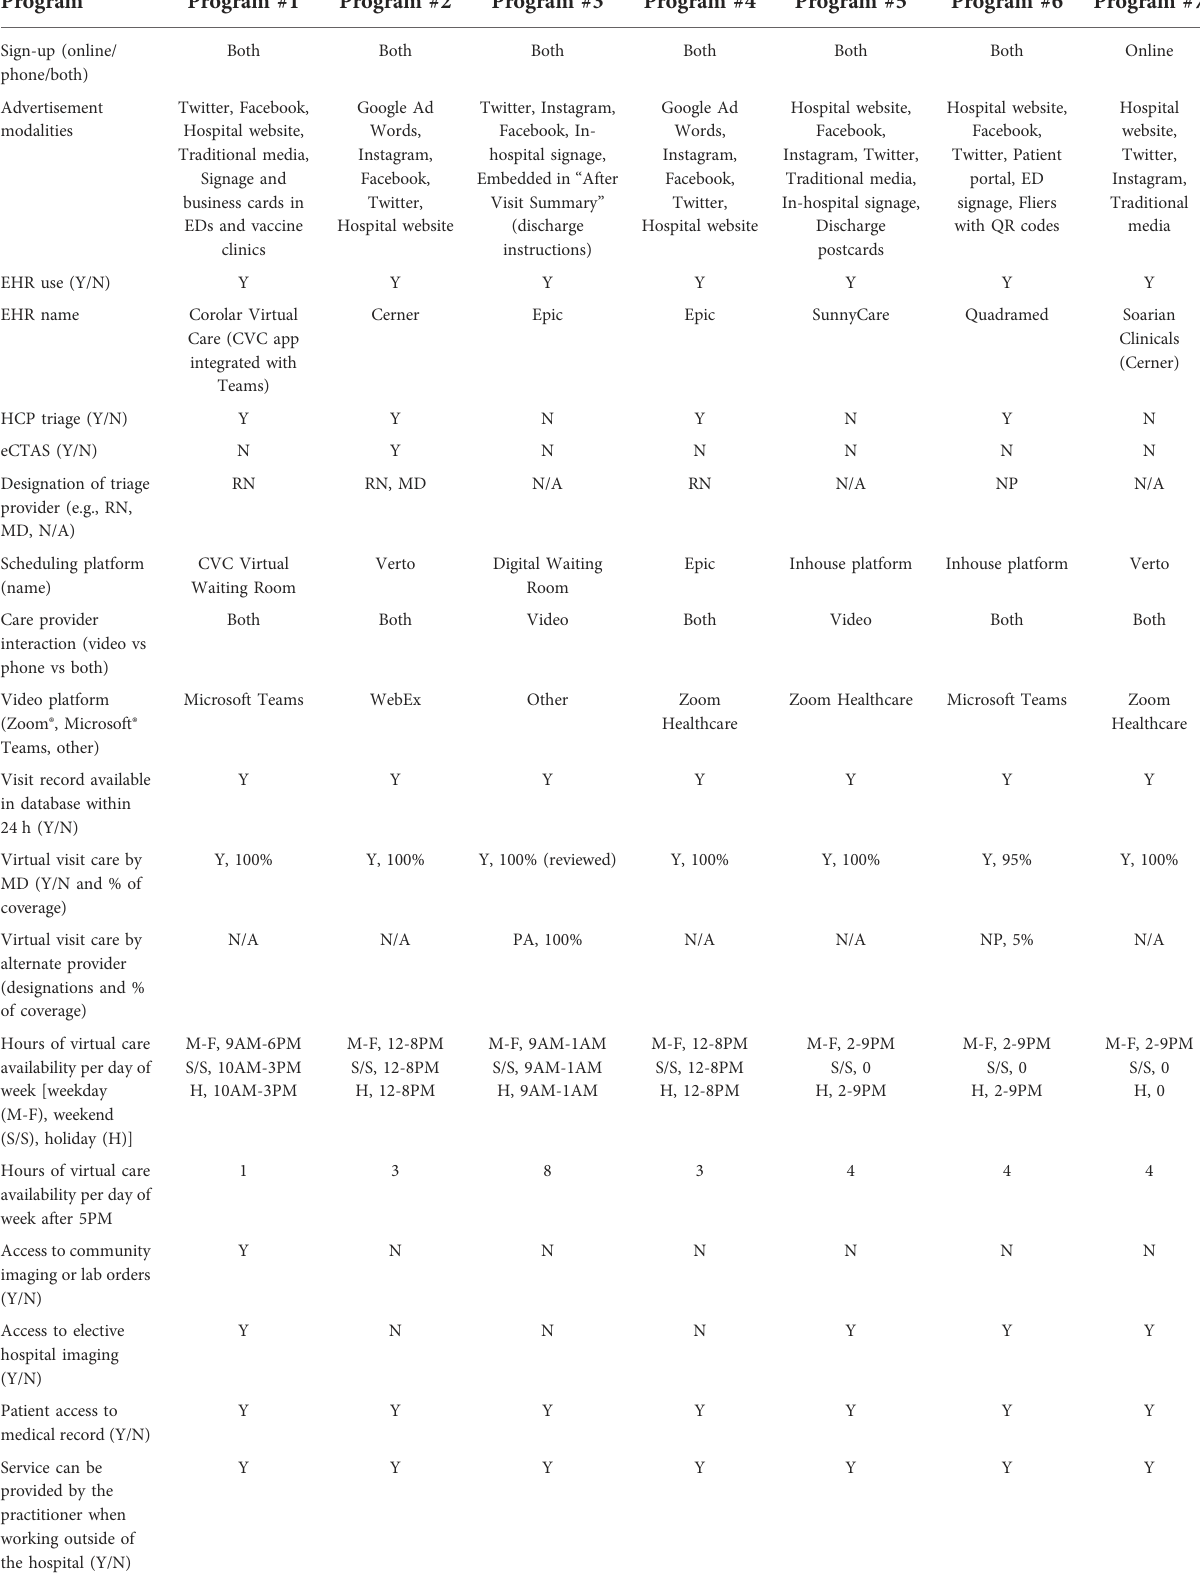
TABLE 1 Virtual urgent care pilot program models. Program Sign-up (online/ phone/both)